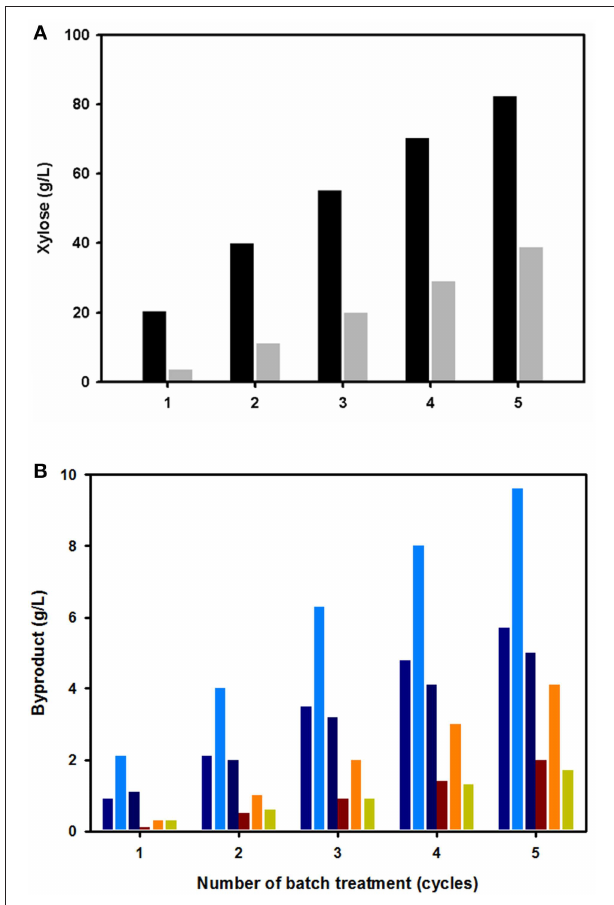
FIGURE 3 | Effect of the number of diluted acid batch pretreatments on the concentrations of extracted soluble substances in the acidic wastewater (black bars) and washing solution (gray bars). Xylose, the most abundant sugar substance (A) , and other minor soluble byproducts [glucose (blue-violet), acetate (blue), and furfural (deep blue)] (B) remained in the acidic wastewater. The minor soluble compounds [glucose (brown), acetate (orange), and furfural (yellow-green)] in the washing